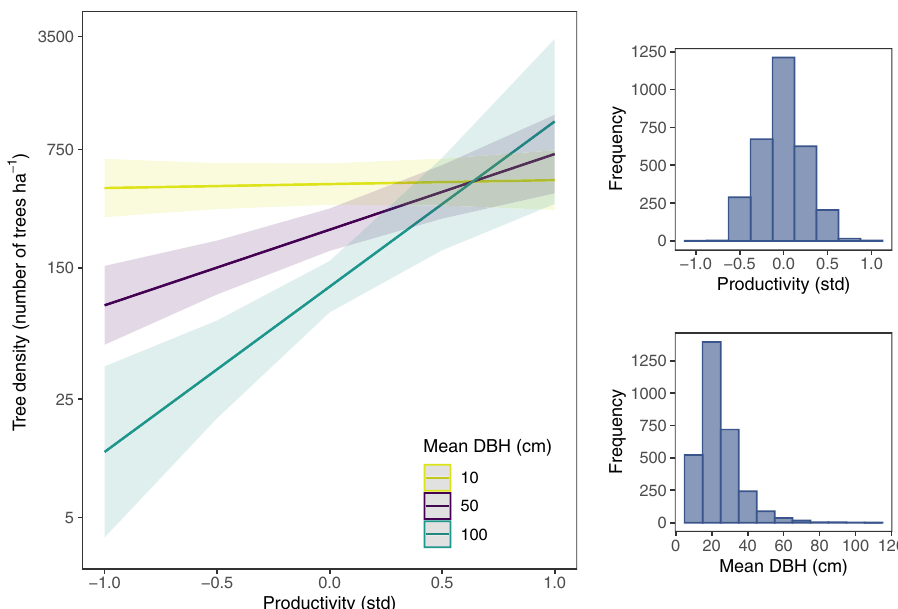
Fig. 4 The productivity-tree density relationship is contingent upon mean DBH. Graphical representation of tree density as a function of the interaction between mean tree size (Mean DBH) and productivity calculated as 0.232NPP + 0.237CEC (being NPP the climatic Net Primary Productivity, and CEC the Cation Exchange Capacity). Shadowed areas represent the 95% con fi dence intervals of model predictions. The right panels display the distributions of mean DBH and productivity, respectively. Results support the idea that the positive in fl uence of productivity on tree density reinforces towards higher values of mean tree